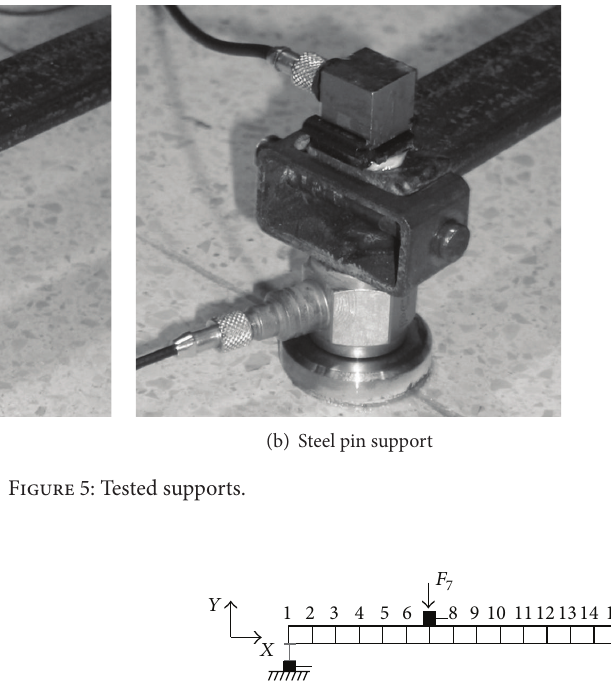
Figure 7: Schematic representation of the experimental setup for application 1.